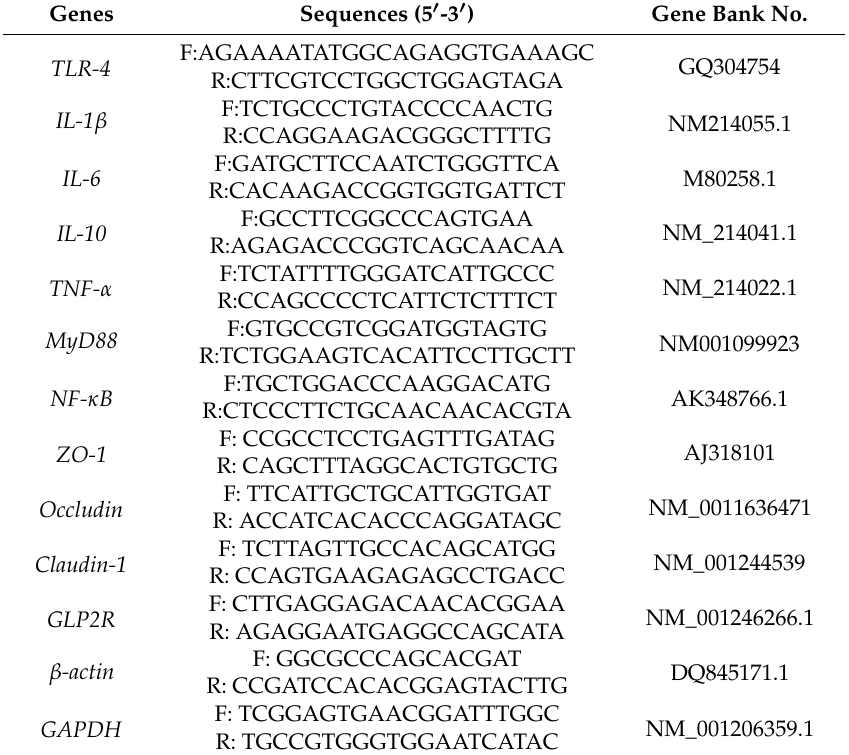
Table 1. Oligonucleotide primers used for a relative-quantitative real-time PCR